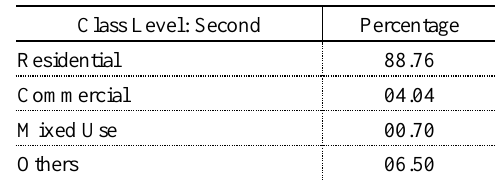
Table 9: Results for second level building classification